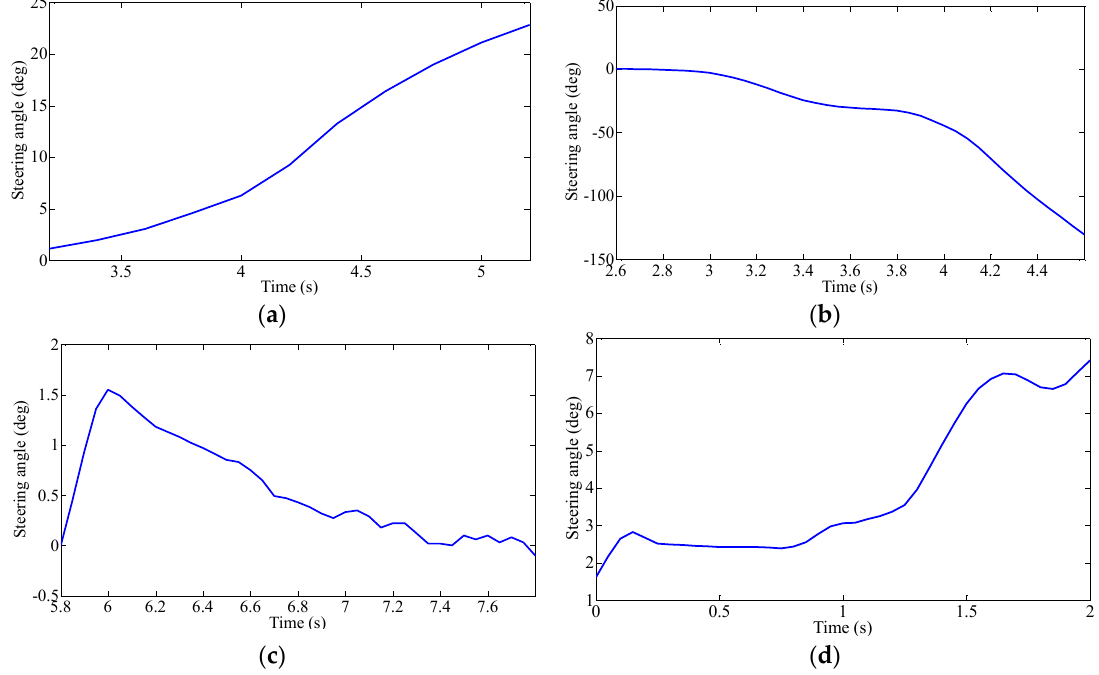
Figure 4. Steering angle under different steering conditions: ( a ) turning right; ( b ) U-turn; ( c ) lane keeping; ( d ) lane changing.